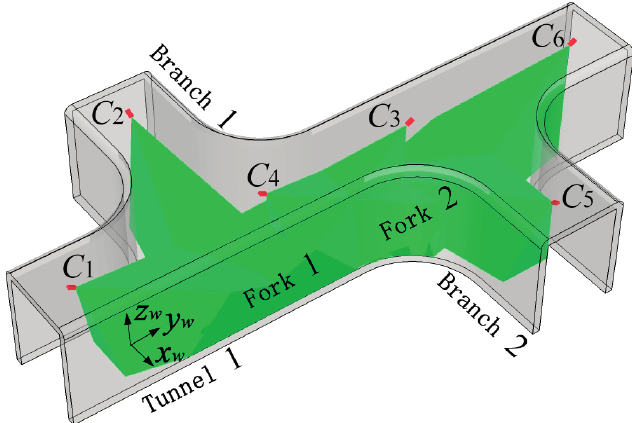
Figure 2. Scene of miner localization in underground coal mine with bifurcated